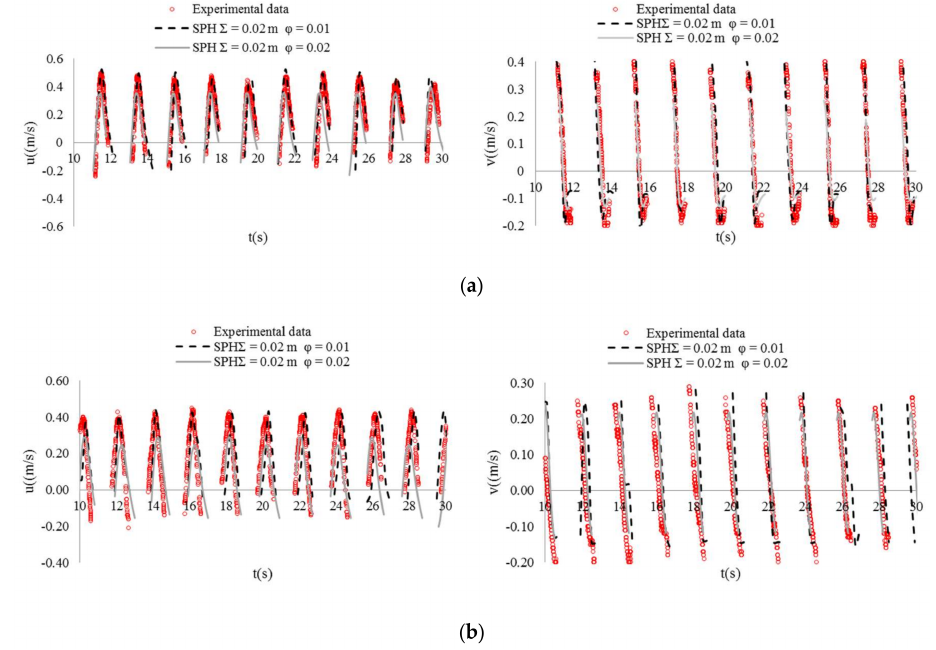
Figure 5. Effect of the velocity smoothing parameter φ v on the numerical simulations: computed and measured horizontal and vertical velocities in ( a ) Section 2 and ( b ) Section